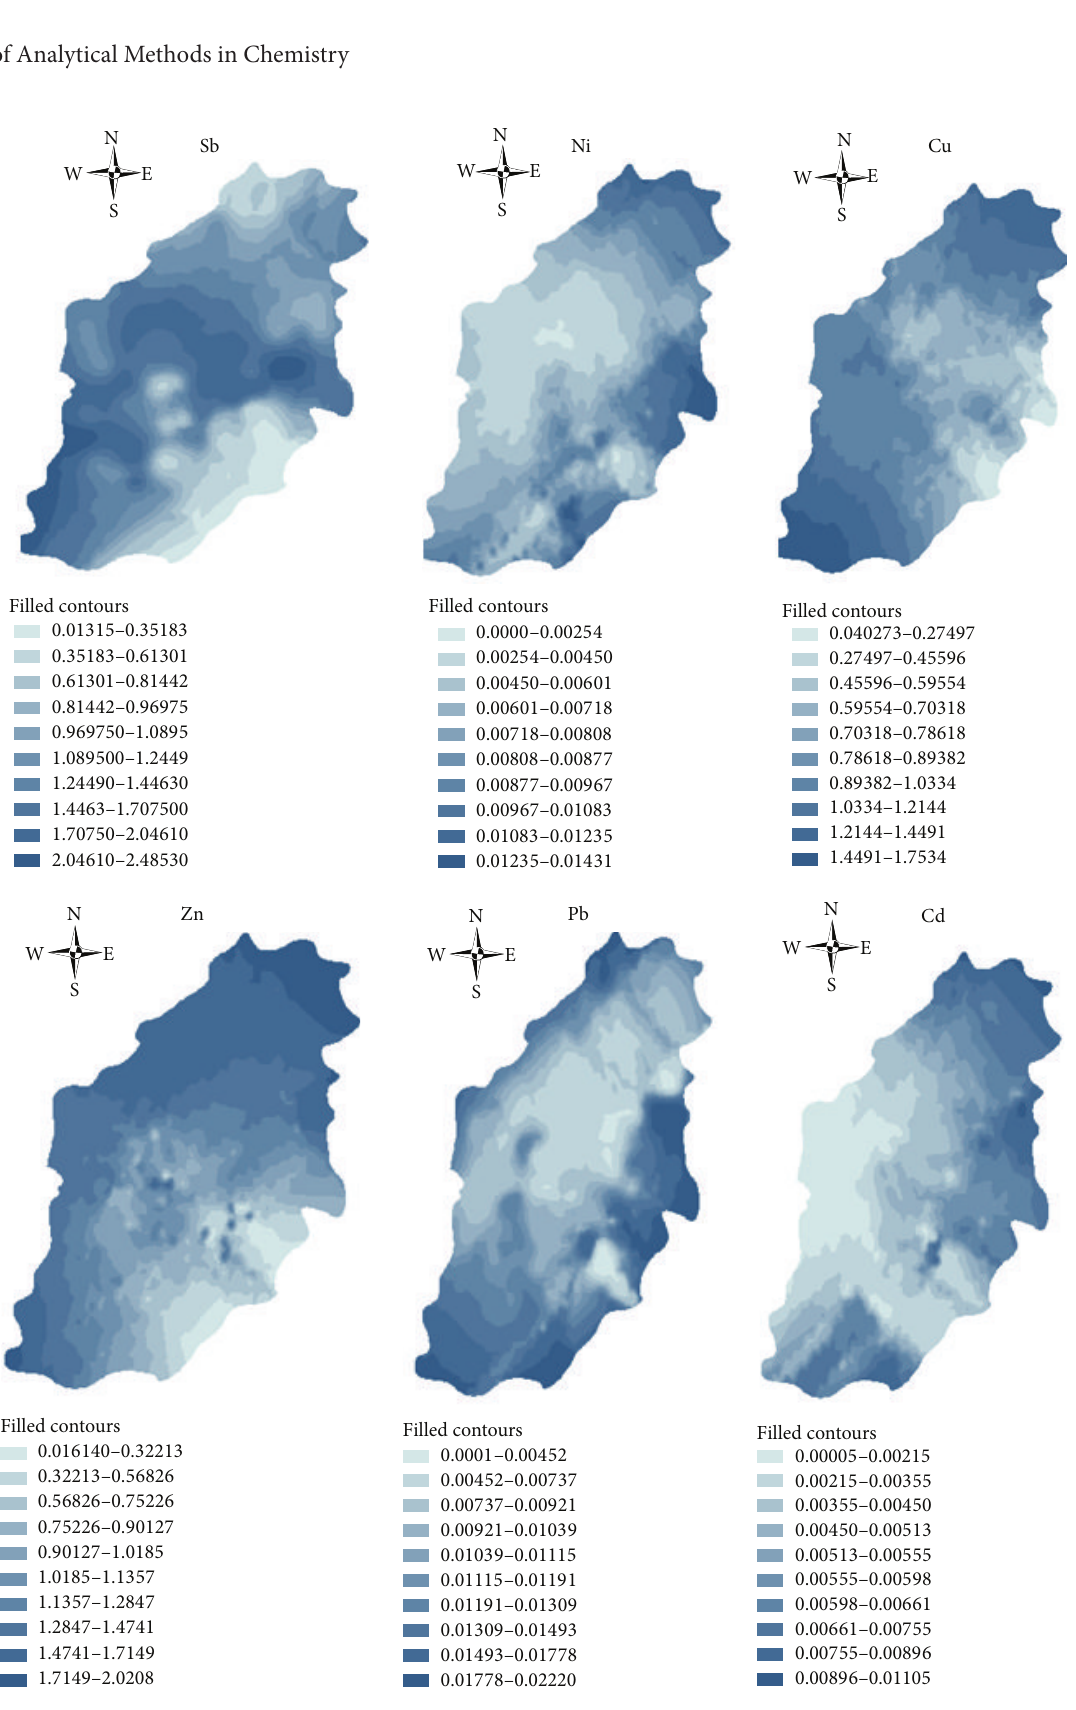
Figure 6: The predicted map of spatial distribution of Sb, Ni, Cu, Zn, Cd, and Pb in surface runoff in the antimony mine with Kriging